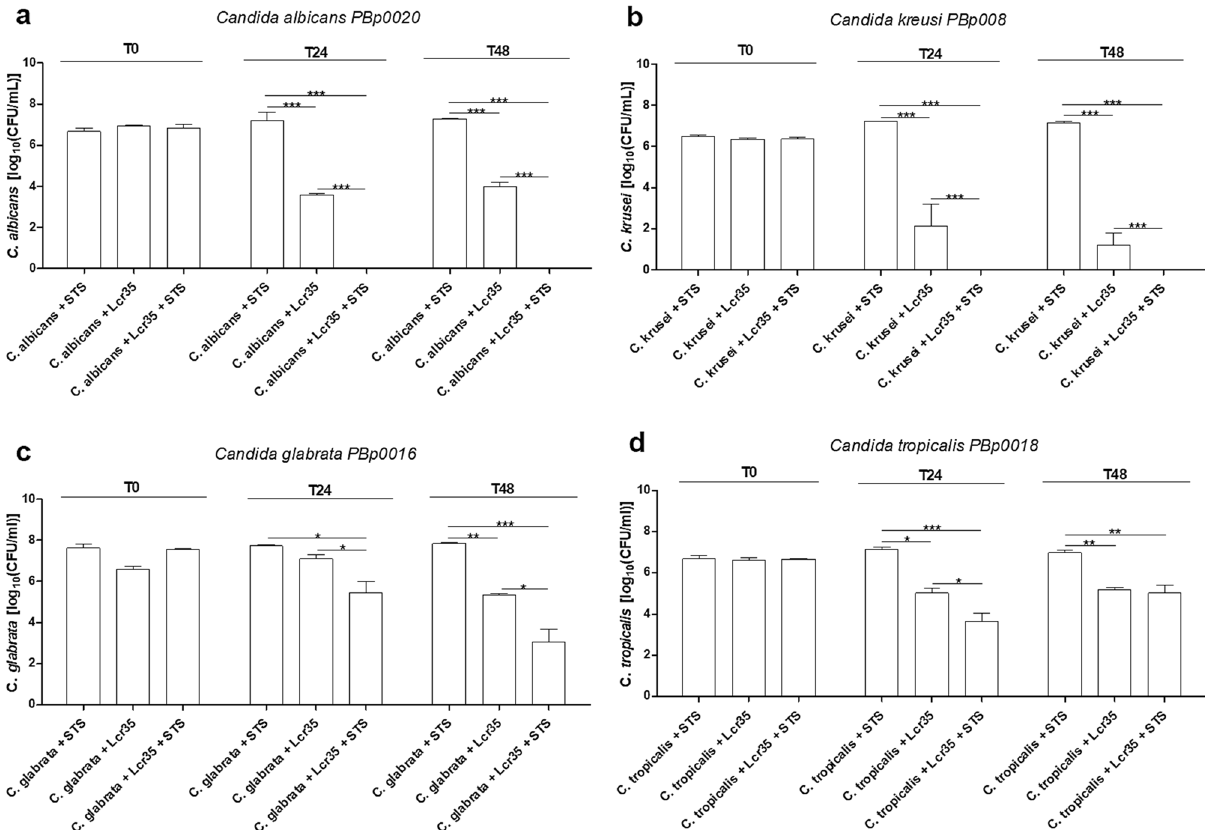
Figure 2. Viability of four clinical Candida spp co-incubated with Lcr35 with and without STS (1 g/l). C. albicans ( a ), C. krusei ( b ), C. glabrata ( c ), C. tropicalis ( d ) viability determined at strain contacting (T0), after 24 h (T24) and 48 h (T48) of co-incubation with Lcr35 with or without 1 g/l of STS. Candida spp. controls were incubated without Lcr35 and with 1 g/l STS. N = 3, *p < 0.05, **p < 0.01, ***p < 0.001 (one-way ANOVA test and Bonferroni